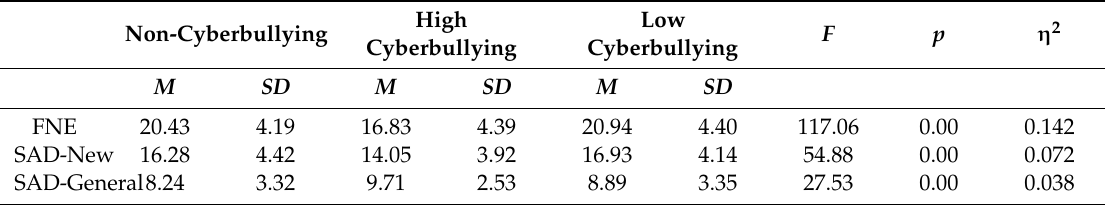
Table 3. Means and standard deviations of social anxiety between classes and statistical significance.